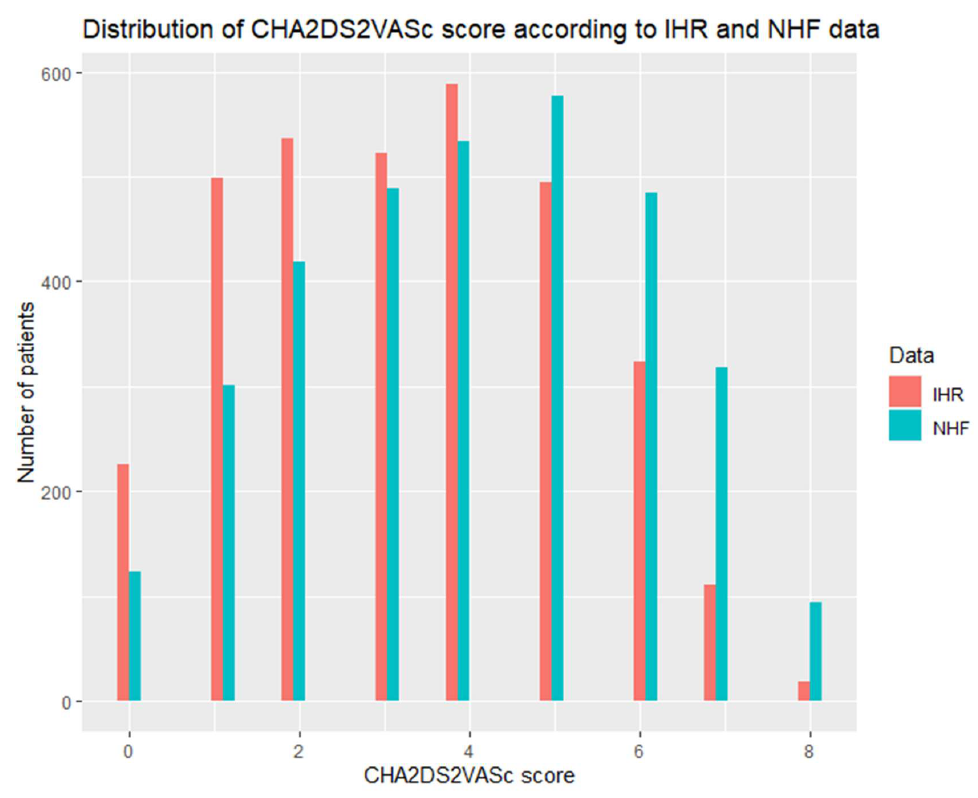
Figure 2. Distribution of HASBLED score within the cohort according to IHR and NHF data.